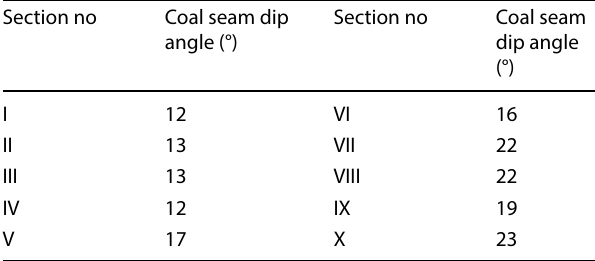
Table 2 Variation in coal seam dip angle in Luzigou anticline region Section no